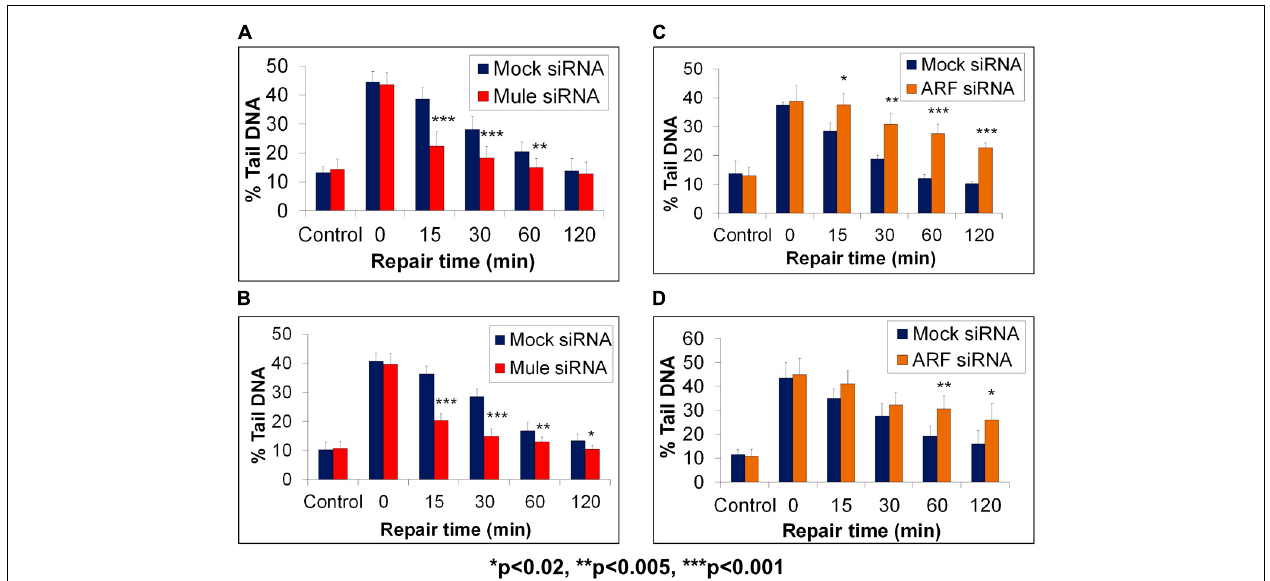
FIGURE 4 | Modulation of BER through Mule-dependent regulation of Pol β protein levels, as revealed by the in-gel DNA repair comet assay. HeLa cells (A,C) orWI-38 cells (B,D) were treated with Lipofectamine transfection reagent (LifeTechnologies, Paisley, UK) in the absence (Mock siRNA) and presence of Mule siRNA (A,B) or ARF siRNA (C,D) for 72 h. Cells were analyzed using the in-gel DNA repair comet assay following treatment in suspension with 20 μ M hydrogen peroxide for 5 min and allowing for DNA